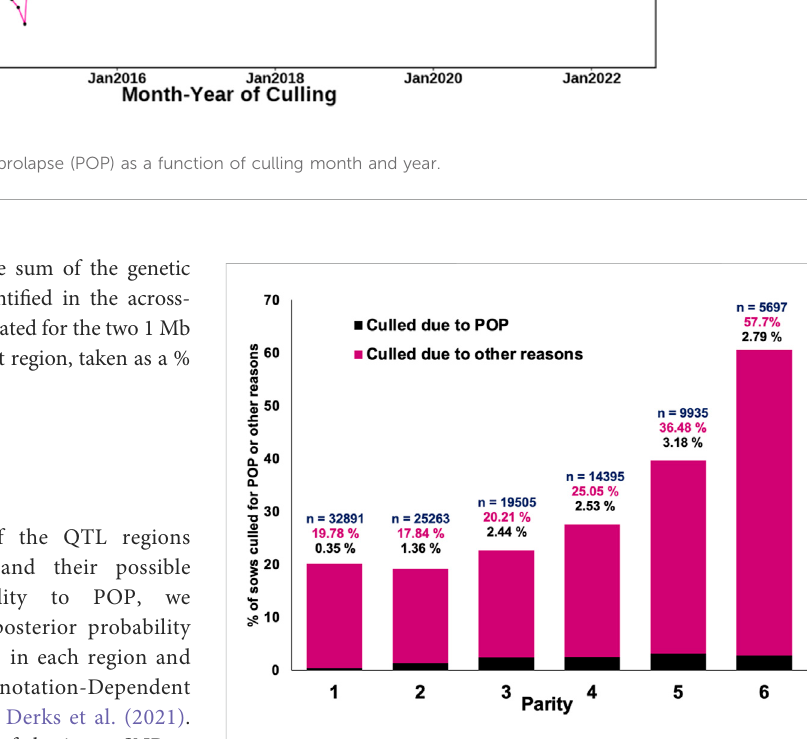
FIGURE 2 Percentage of sows that died or were culled due to pelvic organ prolapse (POP) or culled/died for other reasons by parity, where n denotes the total number of sow records present in that